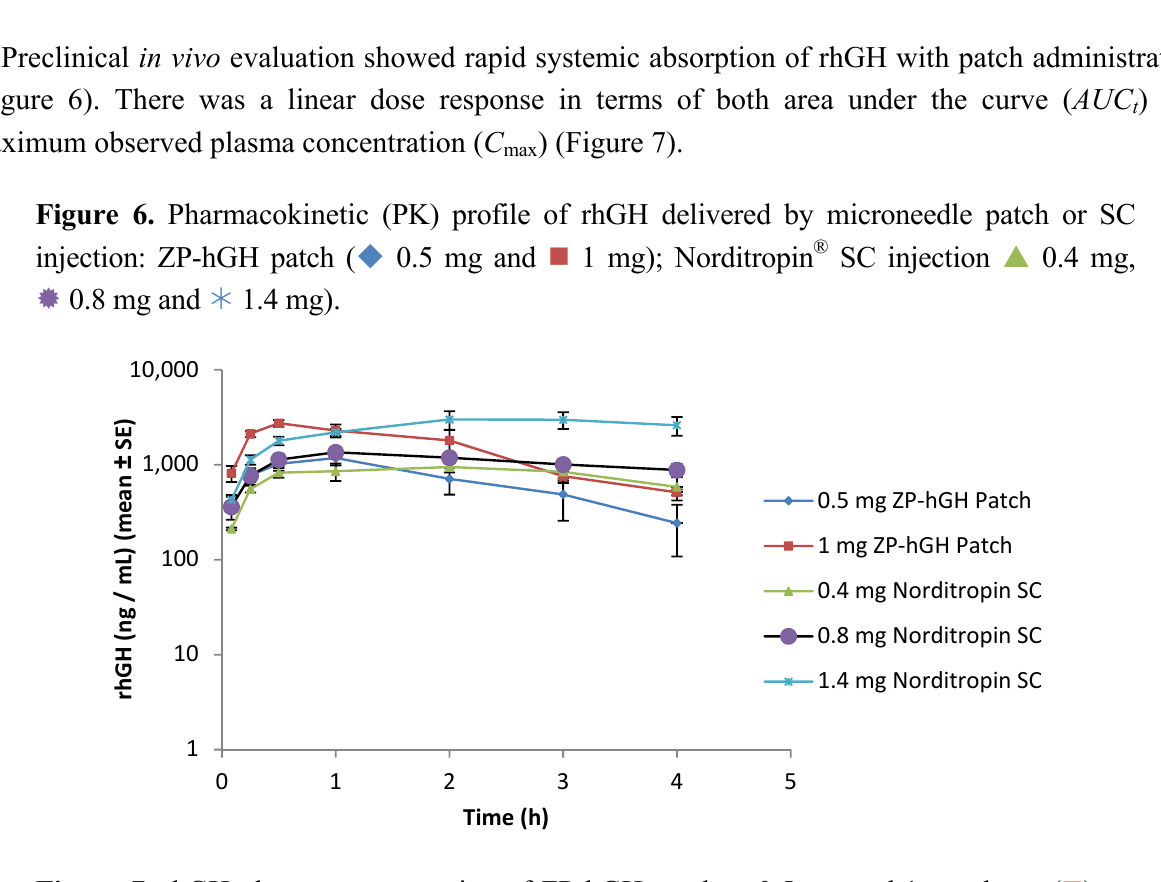
Figure 7. rhGH plasma concentration of ZP-hGH patch at 0.5 mg and 1 mg doses (  ) vs. Norditropin ® SC injection over the range of 0.4 to 1.4 mg ( 